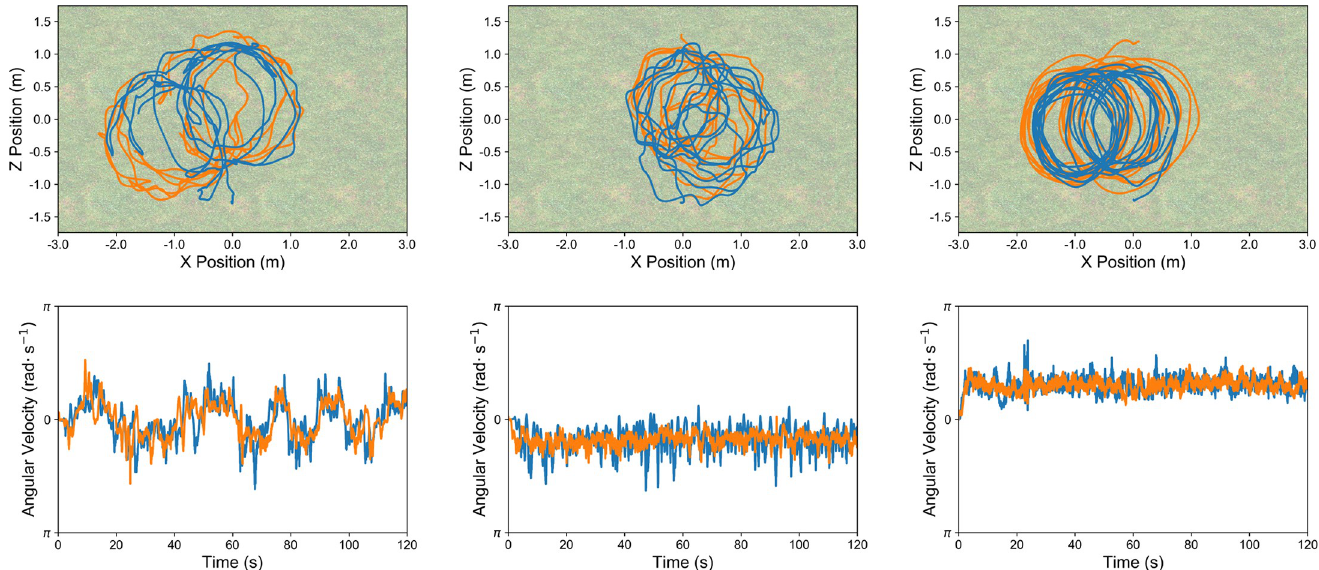
Fig 4. Representative examples of intermittent clockwise (CW)/counterclockwise (CCW) (left, from low-speed condition), continuous CW (center, from medium-speed condition) and continuous CCW (right, from high-speed condition) circling behavior observed in the experiment with human participants. The top row shows the paths taken by participants and the bottom row shows their corresponding angular velocity time series of both participants with respect to the TAs’ mean position at each timestep. Regardless of the mode of behavior, participants’ movements remained coordinated with each other, maintaining an angular difference of � 180˚ with respect to the target agents’ (TAs’) mean position. See S1–S3 Videos for the accompanying videos of the left, center, and right panels,